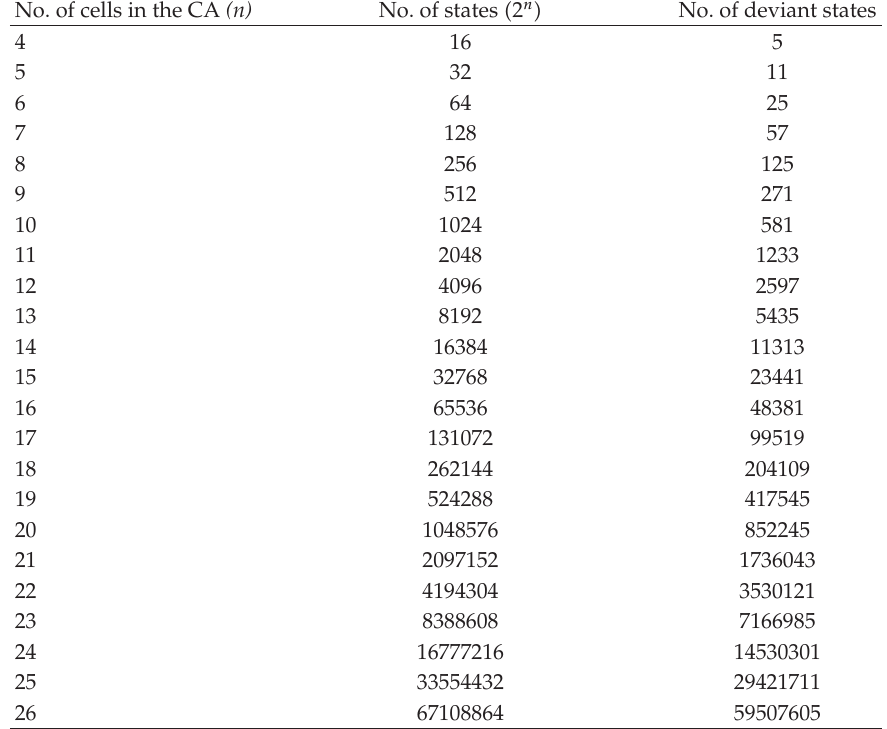
Table 9: Table showing the variation in the number of deviant states for a 1:7 rule with CA length. No. of cells in the CA (n) No. of states (cid:2) 2 n (cid:3) No. of deviant states